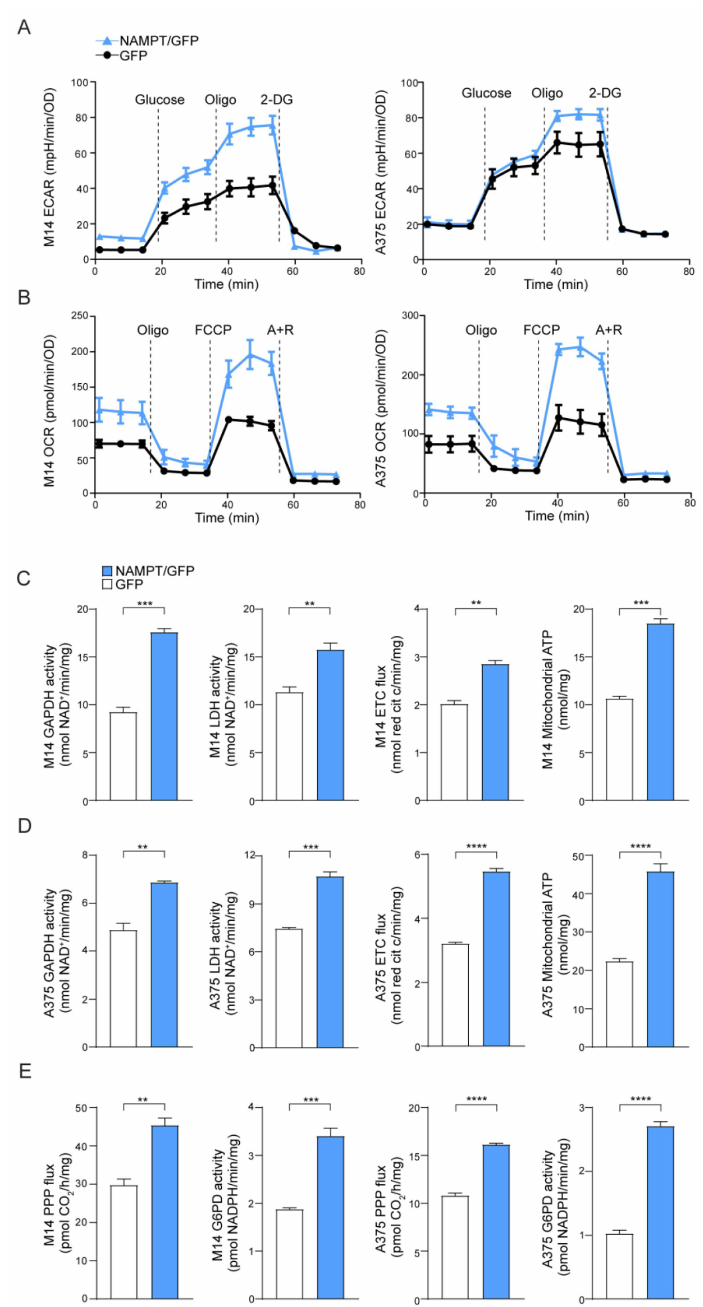
Figure 1. Nicotinamide phosphoribosyltransferase (NAMPT) over-expression boosts metabolic pathways. ( A ) Extracellular acidification rate (ECAR) and ( B ) O2 consumption rate (OCR) measured in M14 and A375 NAMPT / GFP (light blue) vs. GFP (black) variants using the Seahorse XFe Analyzer (representative profile of 3 independent experiments). Oligo: oligomycin, 2-DG: 2-Deoxy-D-glucose, FCCP: carbonyl cyanide p-trifluoromethoxyphenylhydrazone, A + R: antimycin + rotenone. ( C , D ) Histograms showing metabolic measurements of GAPDH and LDH activity (nmol NAD + / min / mg protein), electron transport chain (ETC) flux (nmol red cit c / min / mg protein), and mithocondrial ATP (nmlo / mg protein) in M14 ( C ) and A375 ( D ), comparing NAMPT / GFP vs. GFP variants. Cumulative data of 3 independent experiments. Unpaired t test. ( E ) Pentose phosphate pathway flux (PPP, pmolCO2 / h / mg protein) and G6PD activity (nmol / min / mg protein) in M14 and A375 comparing NAMPT / GFP vs. GFP variants. N = 3, unpaired t test. Data in the Figure are presented as the mean ± SEM. Significance was represented as: ** p ≤ 0.01, *** p ≤ 0.001 and **** p ≤